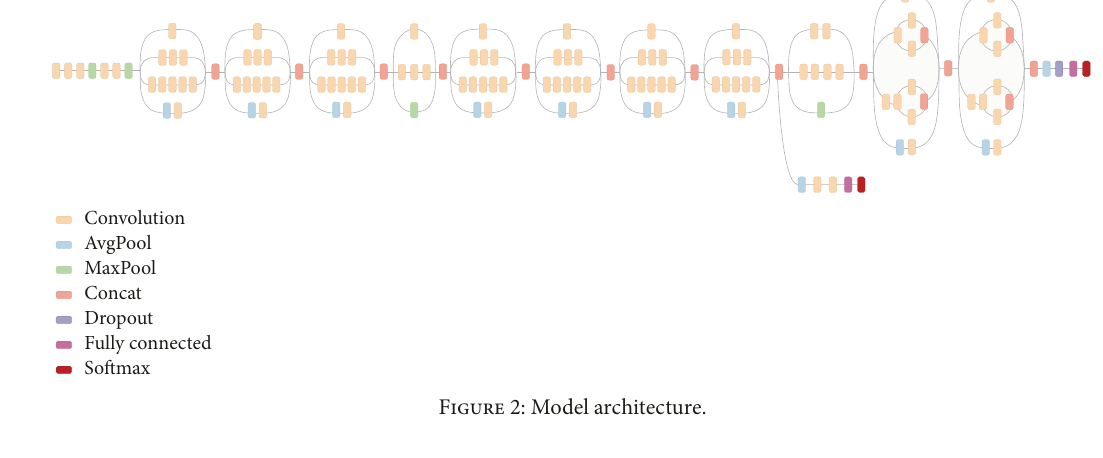
Figure 2: Model architecture.